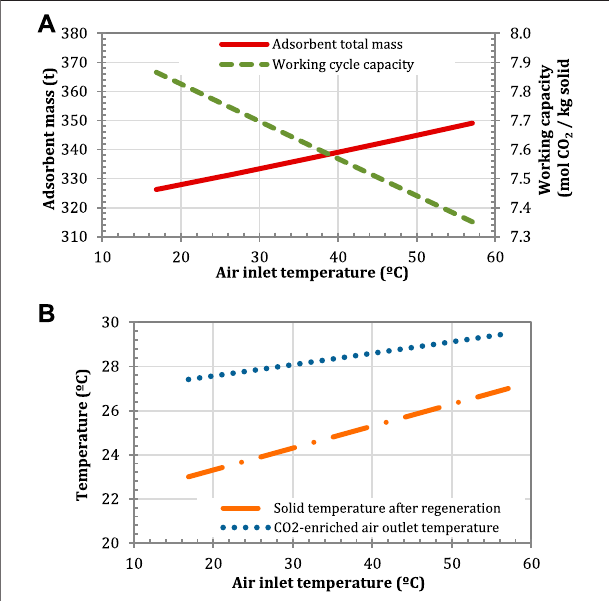
FIGURE 12 | Effect of the air inlet temperature on (A) the adsorbent mass and the working capacity, and (B) on the CO 2 -enriched air and the solid temperatures. Con fi guration: S-EGR in parallel at 70% recirculation ratio.